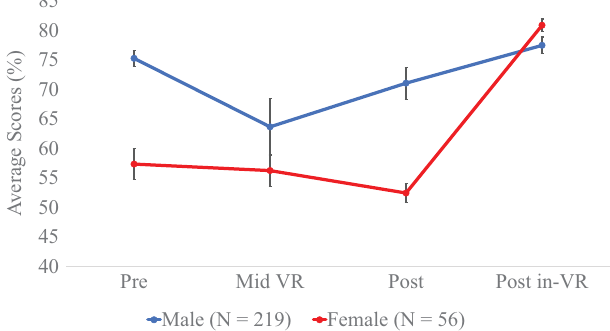
FIG. 8. Average scores at different time points on questions posed in different media, separated by sex. Three students included in other figures are excluded here due to identifiability concerns and/or response completeness.